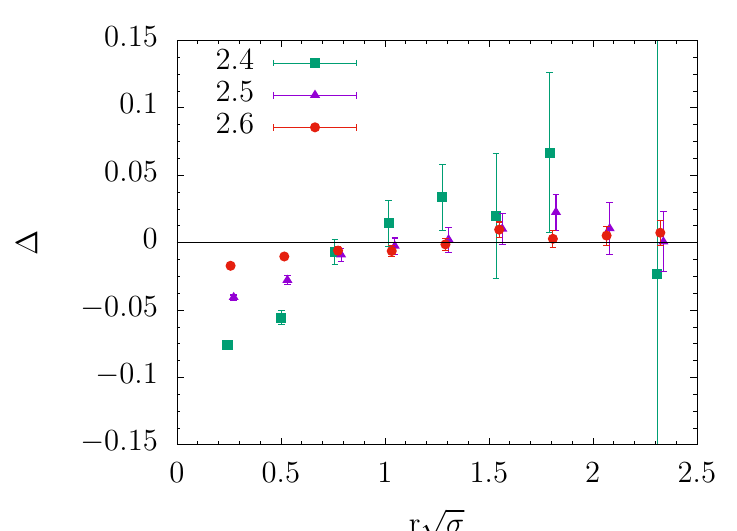
Figure 2. The relative deviation ∆ ( r ) vs. distance r for three values of the lattice spacing.